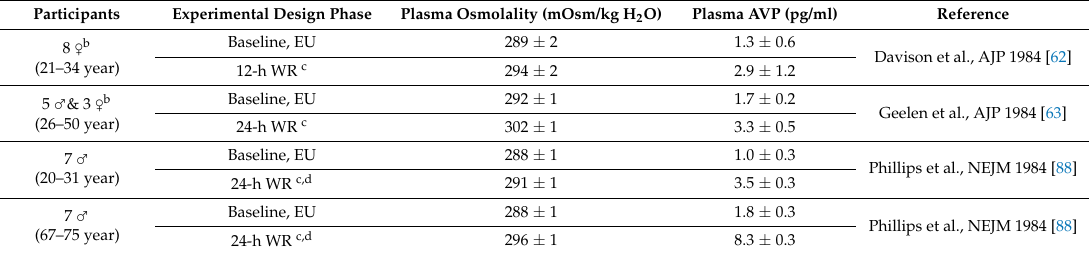
Table 7. Effects of 12-h and 24-h water restriction a on plasma osmolality and AVP